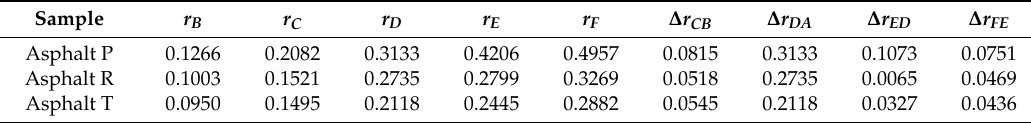
Figure 1. ( a ) Softening points of three kinds of asphalts under different environmental combinations. ( b ) Viscosities of two kinds of asphalts under different environmental combinations. Table 5. r and ∆ r values of softening points.